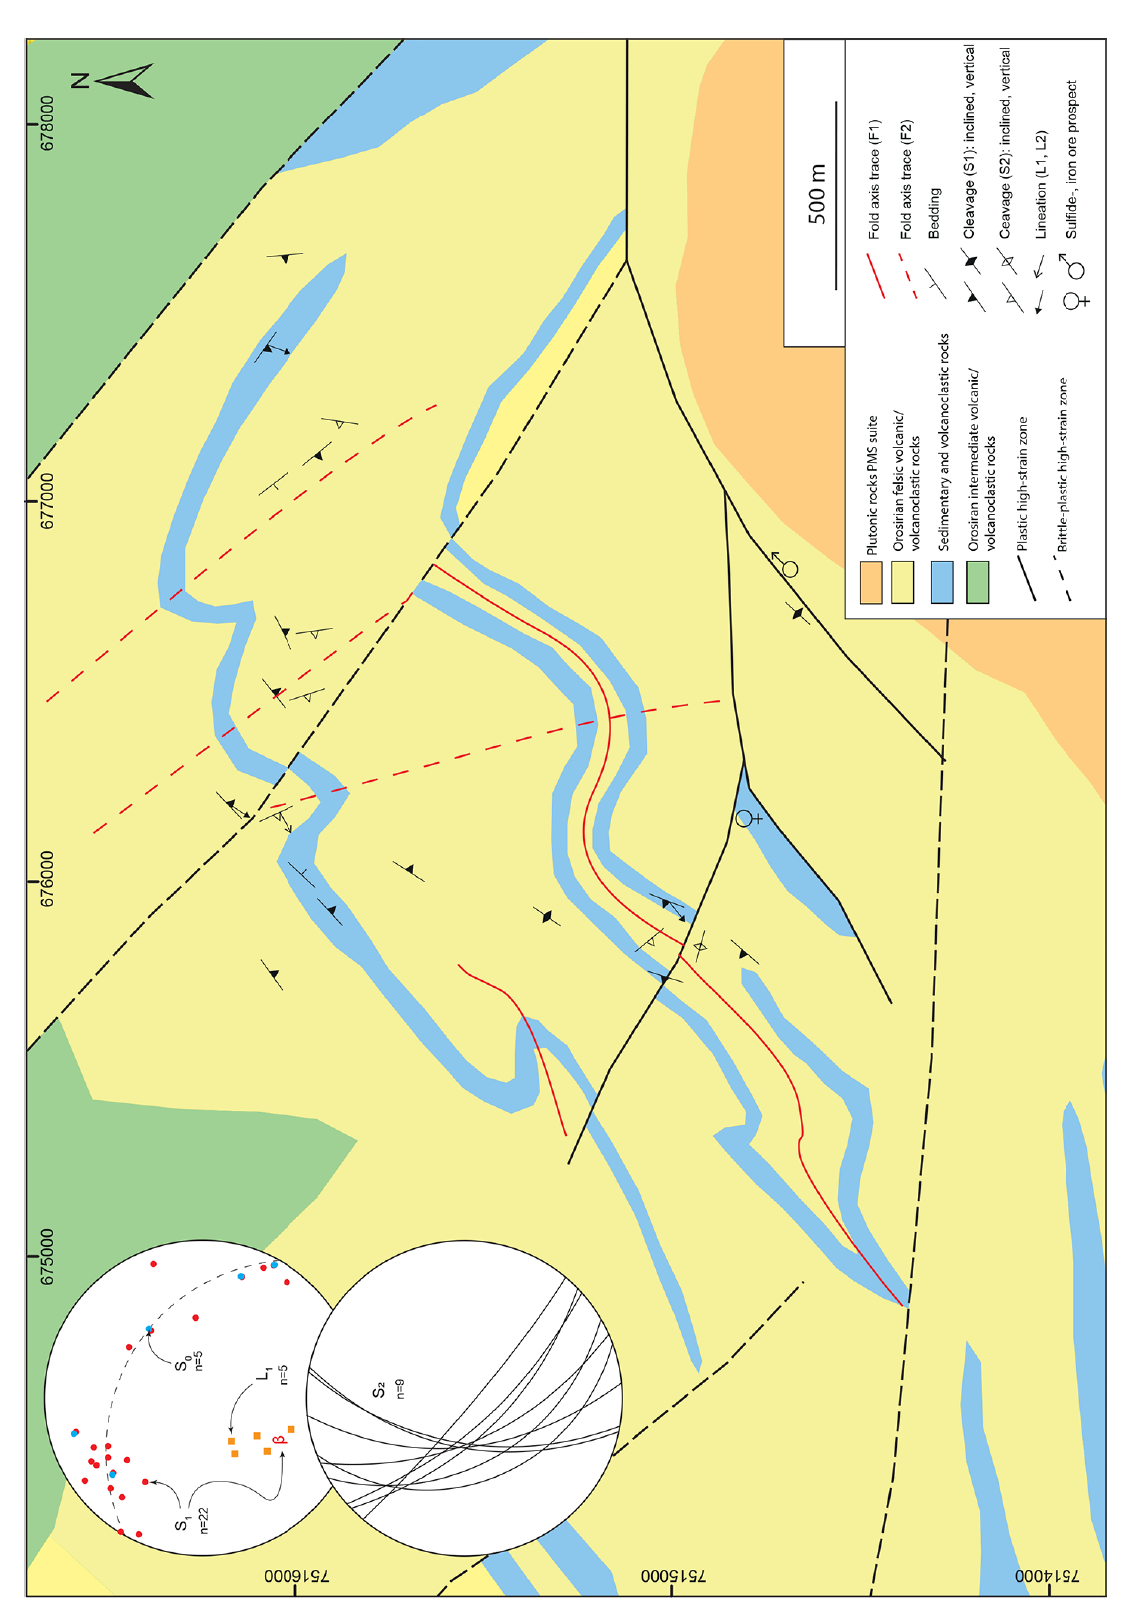
Figure 10. Geological map of the Tjårrojåkka key area. Modified after Offerberg (1967). Coordinates: